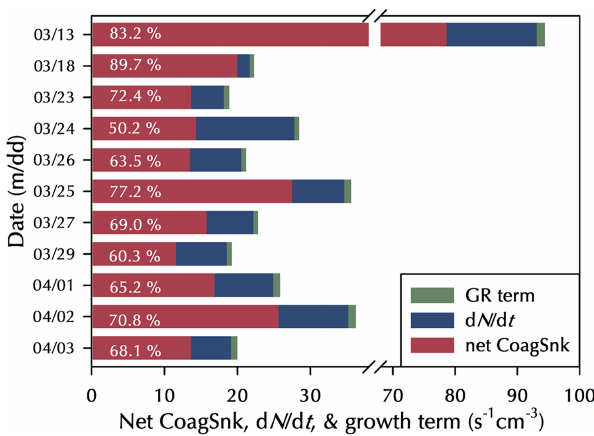
Figure 8. Average contribution of the net CoagSnk, d N /d t , and the condensational growth term (GR term) to the estimated new particle formation rate, J 1 . 5 , on identified typical NPF days. The percentage presented in each column is the relative ratio of the net CoagSnk compared to J 1 . 5 of that NPF event. Note that only the time pe- riod when d N /d t was positive during a NPF event was taken into account when calculating the average